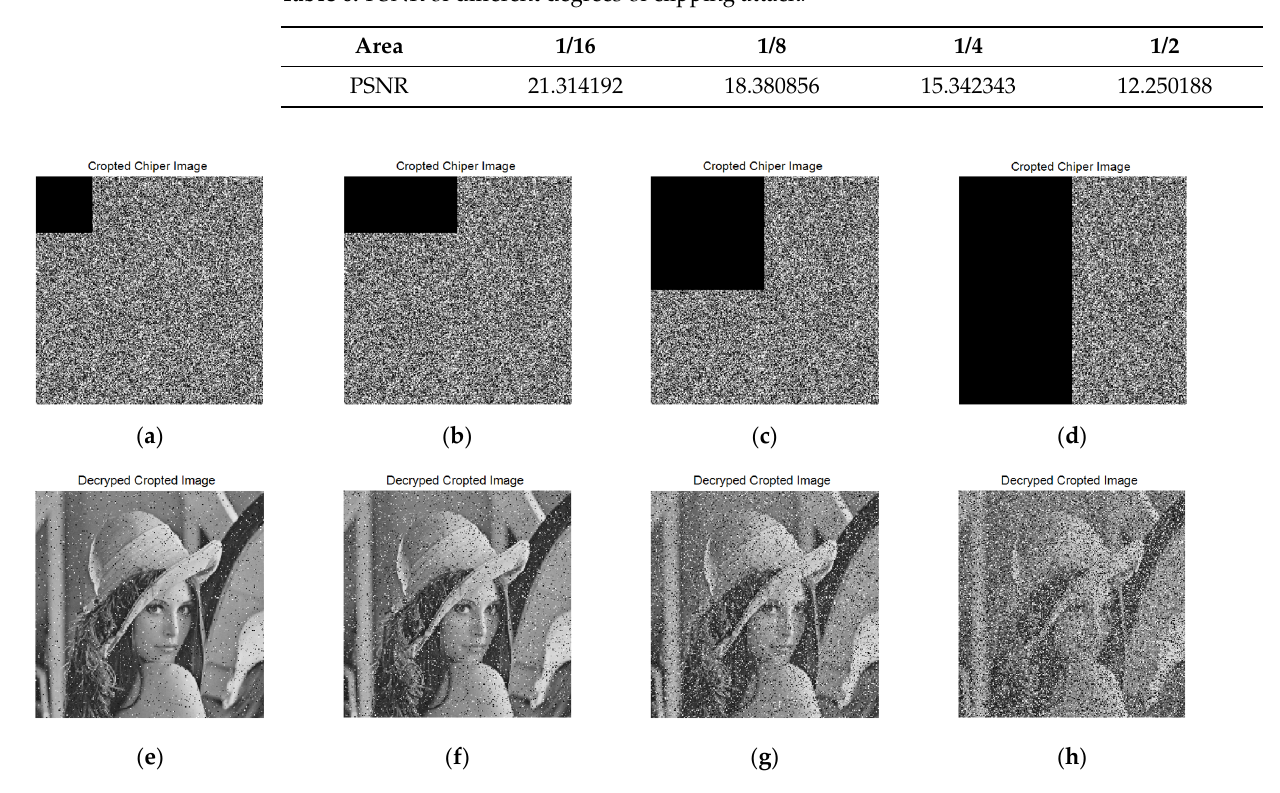
Figure 17. Decrypted images for varying degrees of cropping attacks: ( a ) 1/16 crop; ( b ) 1/8 crop; ( c ) 1/4 crop; ( d ) 1/2 crop; ( e – h ) decrypted images of ( a – d ). Table 7. PSNR for noise attack.